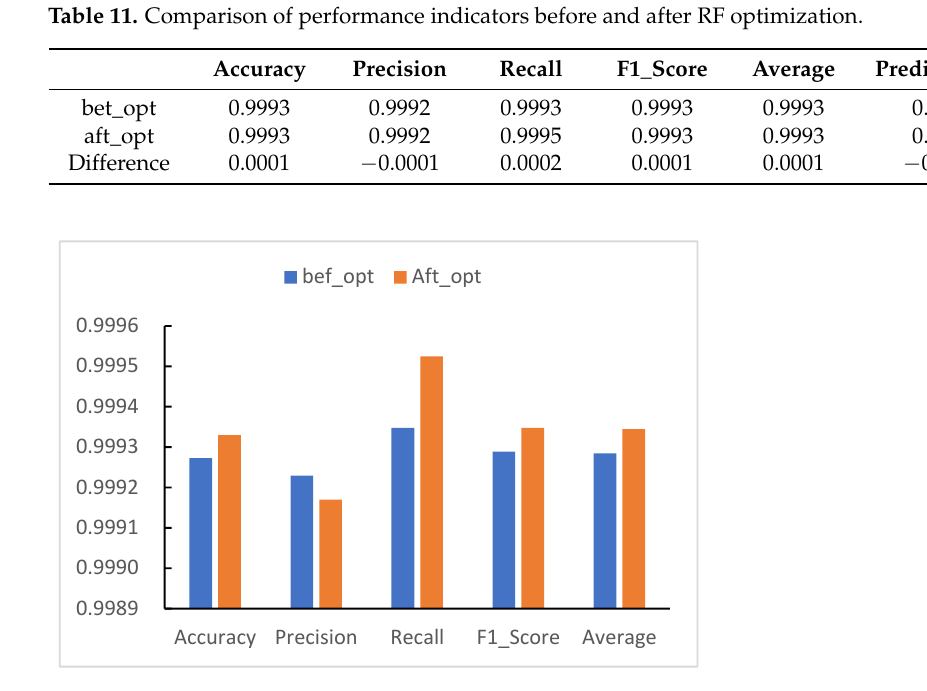
Figure 22. Performance comparison before and after RF optimization.